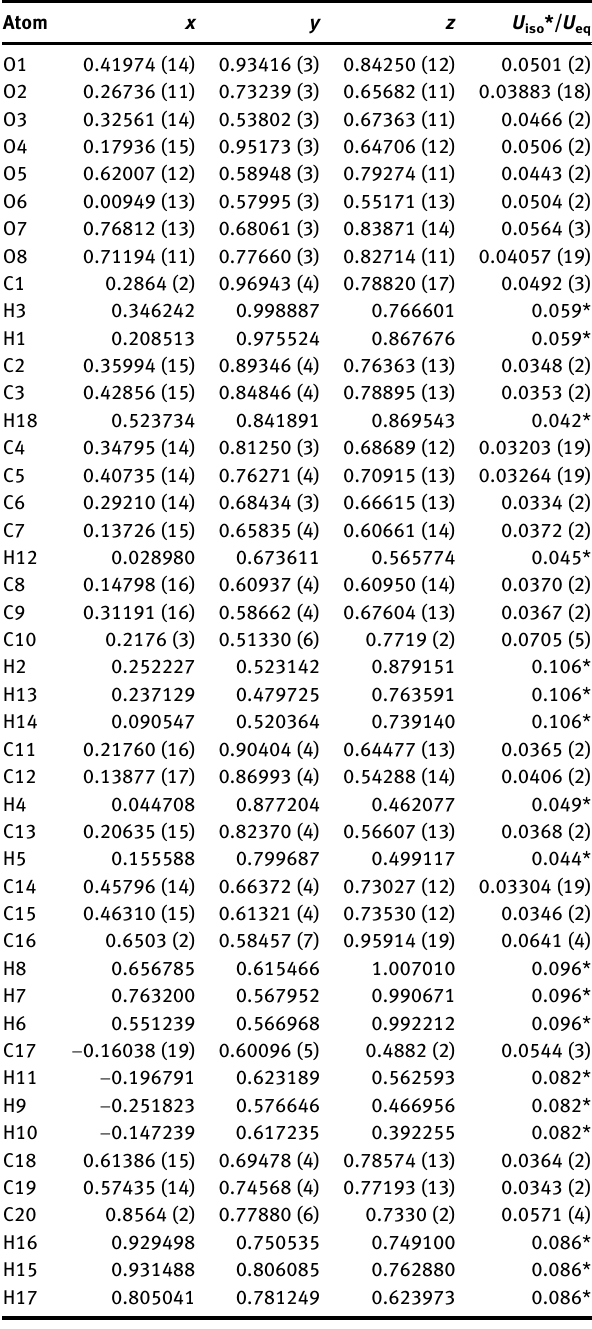
Table  : Fractional atomic coordinates and isotropic or equivalent isotropic displacement parameters (Å 